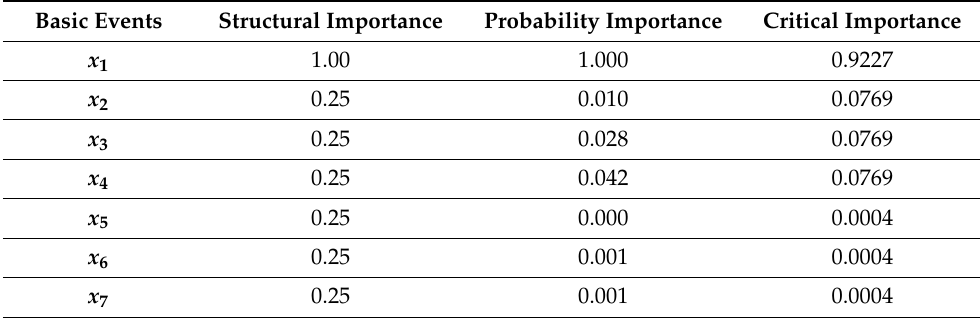
Table 5. Importance of basic